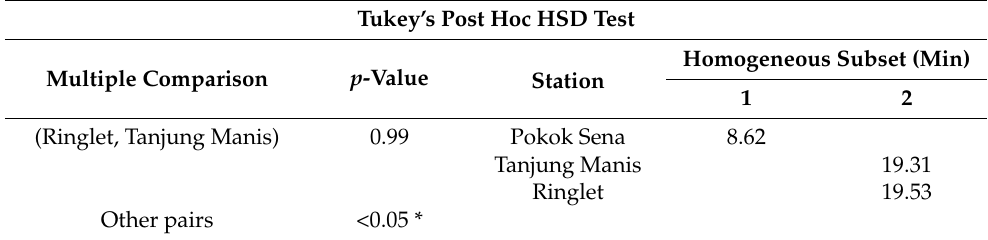
Table 8. Summary of Tukey’s post hoc HSD test for mean response time between category D fire